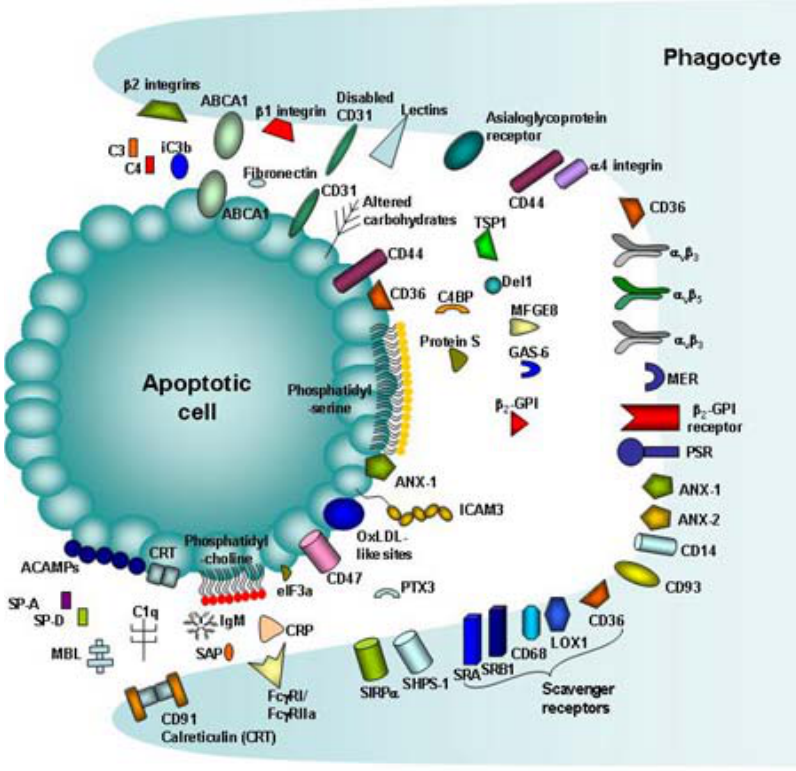
FIGURE 1. The myriad of molecules involved in the regulation of phagocytosis of apoptotic cells. Phagocytic receptors, bridging molecules, and apoptotic ligands interact to coordinate the phagocytosis of apoptotic bodies. These include: C3, complement protein C3; C4, complement protein C4; β 2 integrin, CD11/CD18; iC3b, complement protein iC3b; ABCA1, ATP-binding cassette transporter 1; β 1 integrin, CD29; CD31, platelet endothelial cell adhesion molecule-1 (PECAM1); CD44, receptor for hyaluronic acid; α 4 integrin, CD49d; CD36, thrombospondin receptor; TSP1, thrombospondin 1; Del1, developmental endothelial locus 1; α v β 3 and α v β 5 integrins that bind vitronectin; MFGE8, milk fat globule-EGF factor 8; C4BP, C4-binding protein; GAS-6, growth arrest-specific 6; MER, MER tyrosine kinase; β 2 -GPI, β 2 glycoprotein-1; β 2 -GPI receptor, β 2 glycoprotein-1 receptor; PSR, phosphatidylserine receptor; ANX-1, annexin-1; ANX- 2, annexin-2; CD14, lipopolysaccharide receptor; ICAM3, intercellular adhesion molecule 3; OxLDL-like sites, oxidized low-density lipoprotein-like sites; LOX1, lectin-like low-density lipoprotein receptor-1; CD68, macrosialin; SRB1, scavenger receptor class B1; SRA, scavenger receptor class A; CD47, integrin-associated protein (IAP); SHPS-1, SHP protein-tyrosine phosphatases substitute-1; SIRP α , signal regulatory protein α ; eIF3a, eukaryotic translation initiation factor 3; PTX3, long pentraxin 3; CRP, C-reactive protein; Fc γ RI/Fc γ RIIA, Fc fragment of immunoglobulin G receptor I and IIA; SAP, serum amyloid P component; IgM, immunoglobulin M; CRT, calreticulin; C1q, complement protein C1q; ACAMPs, apoptotic cell- associated molecular patterns; SP-A, surfactant protein A; SP-D, surfactant protein D; MBL, mannose-binding lectin; CD91, α 2 macroglobulin